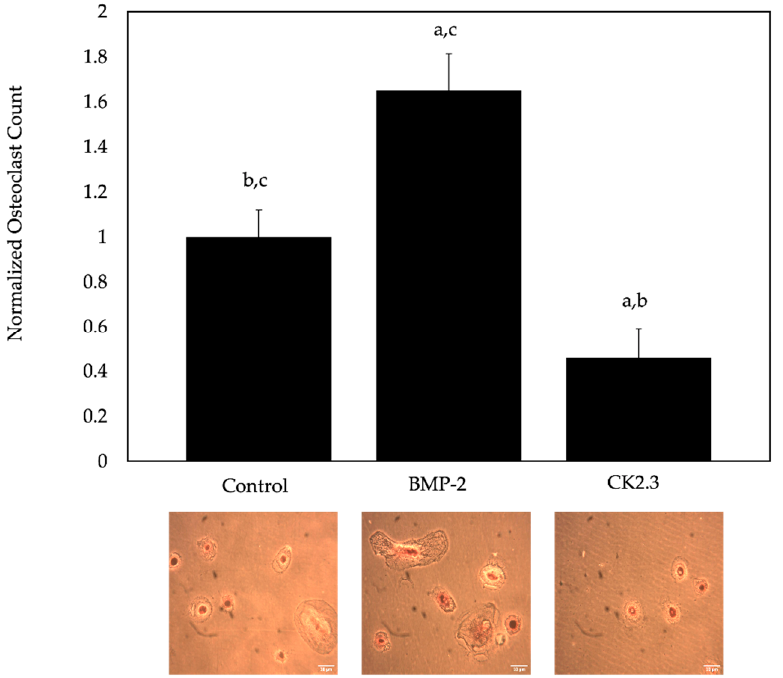
Figure 7. Osteoclastogenesis determined by a TRAP assay. Here, the average osteoclast counts were obtained of cells isolated from human femoral heads of OP female patients. The cells isolated were stimulated with BMP-2, CK2.3, or left US. Ten random images were taken of each well with a 20X objective and counted independently by two researchers. Representative images are displayed underneath the bars. Here, BMP-2 significantly increased osteoclastogenesis, while CK2.3 inhibited osteoclastogenesis, compared to the control group (M-CSF and RANKL only). Data were analyzed using the students’ t -test and Tukey–Kramer HSD statistical tests. All experiments were conducted in technical triplicates. Error bars represent standard error of the mean, and “a, b, c” signifies statistical significance and represents bars 1, 2, and 3 of each group. Scale bars are displayed in the bottom right of each image and set to 10 µM.